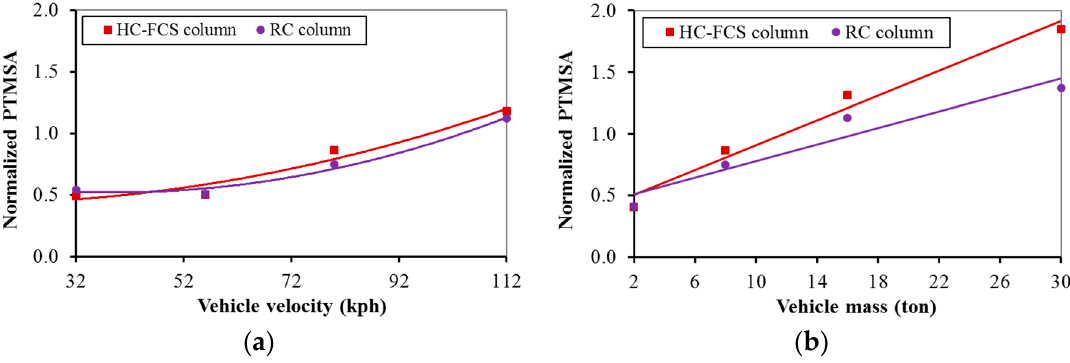
Figure 9. Effects of: ( a ) vehicle velocity and ( b ) vehicle mass on the PTMSA of the HC-FCS and RC columns.